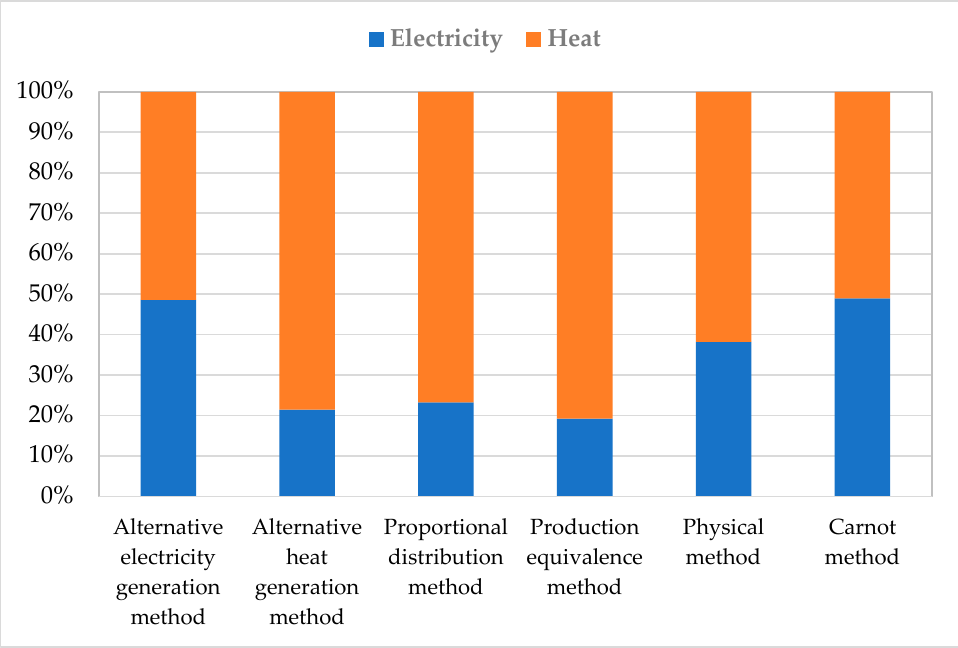
Figure 3. Schematic representation of the CHP plant (E—evaporator; T—turbine; BP—by-pass; G— generator; R—regenerator; C—condenser; PR—preheater; P—pump; HE—heat exchanger).